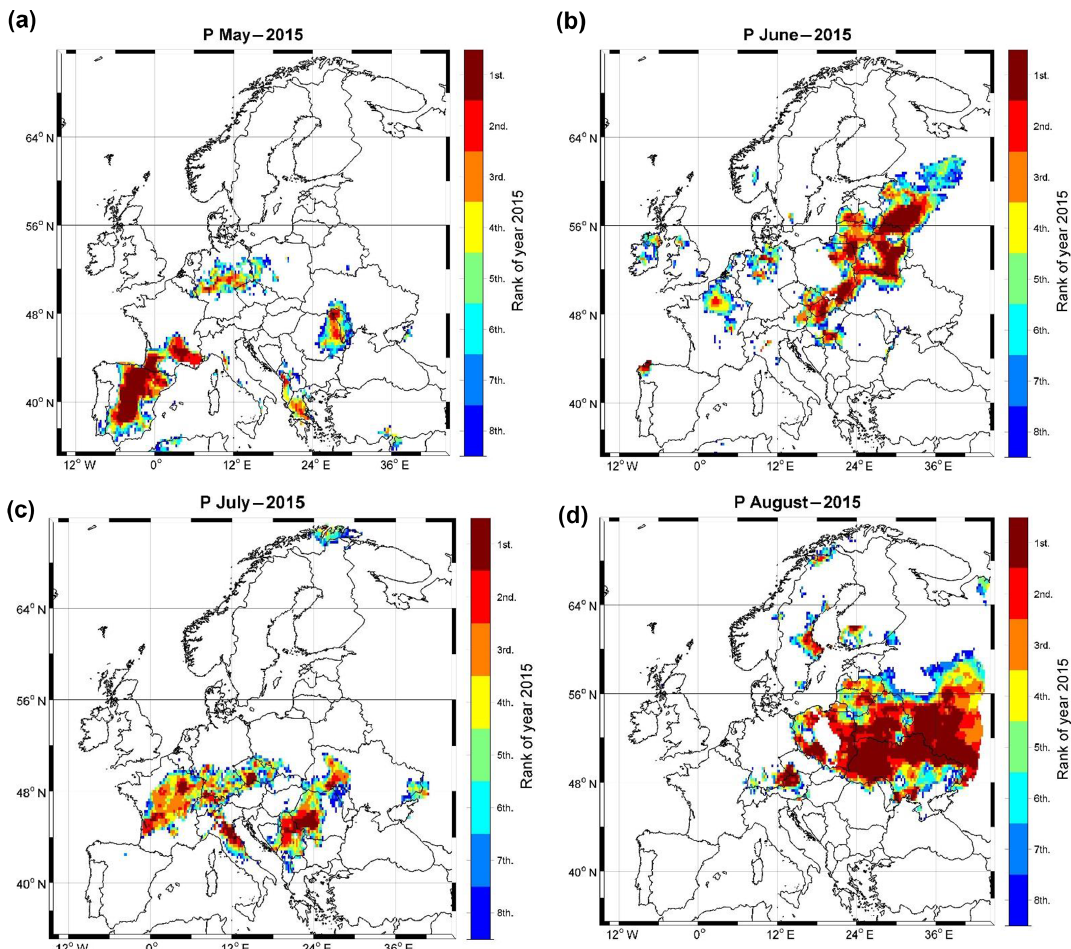
Figure 1. Top-eight ranking of 2015 monthly lowest P : (a) May; (b) June; (c) July and (d) August. 1 means the driest month since 1950, 2 signifies the second driest, etc., and all ranks greater than 8 are shown in white. Analyzed period: